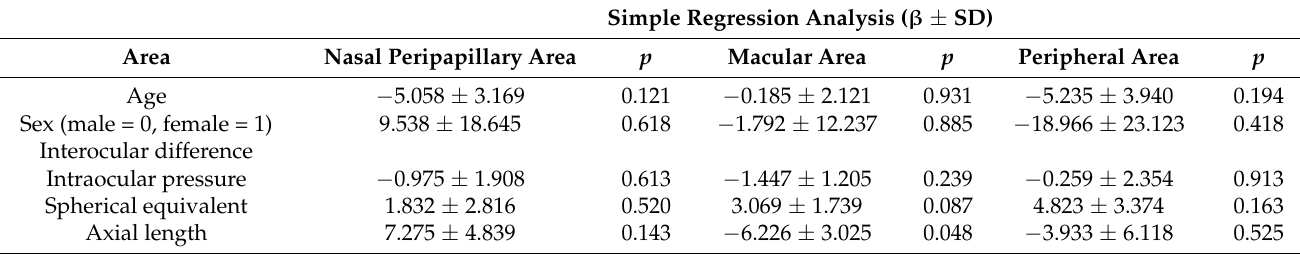
Table 5. Simple regression analysis of the relationships of clinical factors with the mean interocular difference in choroidal thickness by area. Simple Regression Analysis ( β ±